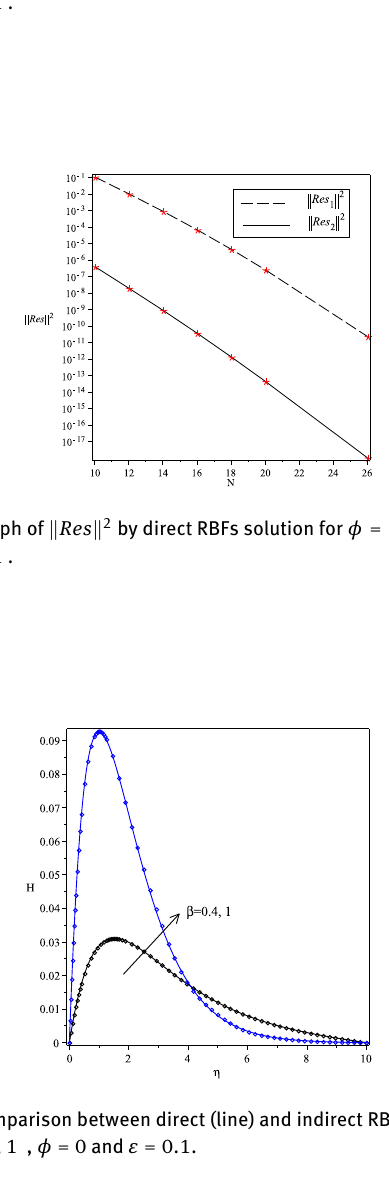
Fig. 10: The profile velocity F (cid:48) ( η ) obtained by the indirect RBFs for different values of ε at β = 6 and ϕ = 0 .